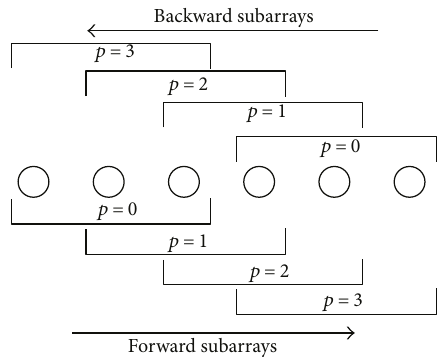
Figure 5: Illustration of the forward and backward subarray formation for a 6 element antenna array and subarray size 3. M = 6, L = 3, and P = 4